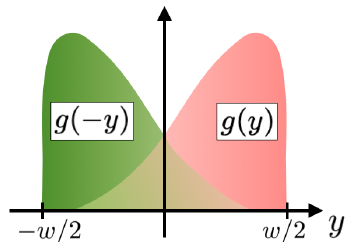
Figure 2. The colored broadened shapes represent the edges’ profiles: g ( y ) for the upper edge (pink) and g ( − y ) for the lower edge (green). They are therefore symmetric around y = 0 and overlap to some